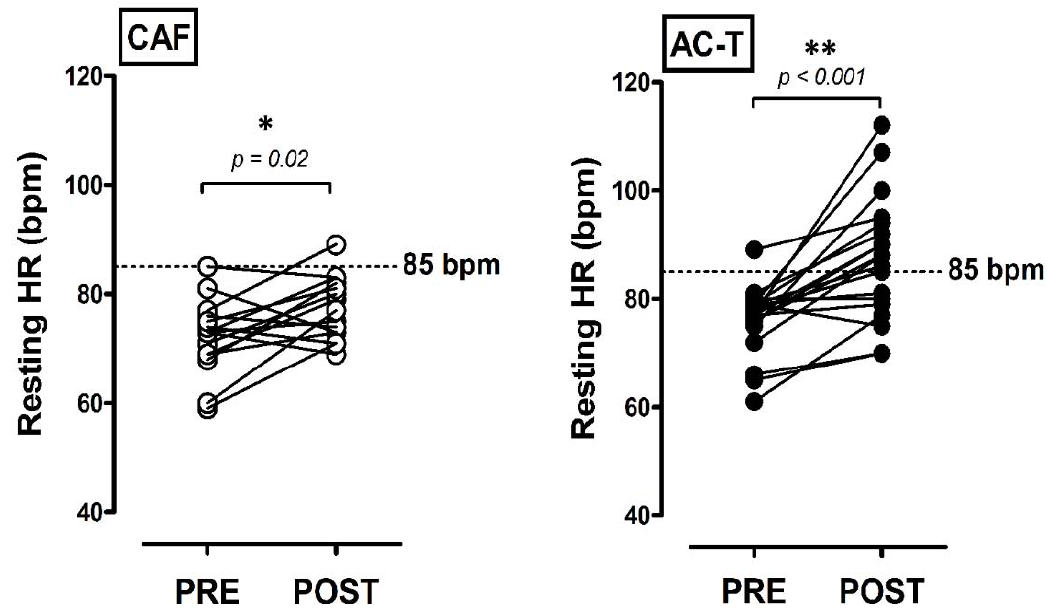
Figure 2. The individual changes in resting heart rate (RHR) with different types of chemotherapy. PRE, baseline before chemotherapy; POST, baseline after the completion of chemotherapy; CAF, cyclophosphamide-anthracycline-5-FU; AC-T, cyclophosphamide-anthracycline + taxane. * denotes the significant difference between PRE and POST ( p < 0.05). ** denotes the significant difference between PRE and POST ( p < 0.001).